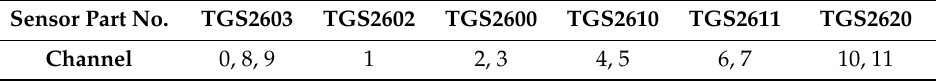
Table 1. Metal oxide gas sensors in the designed array.